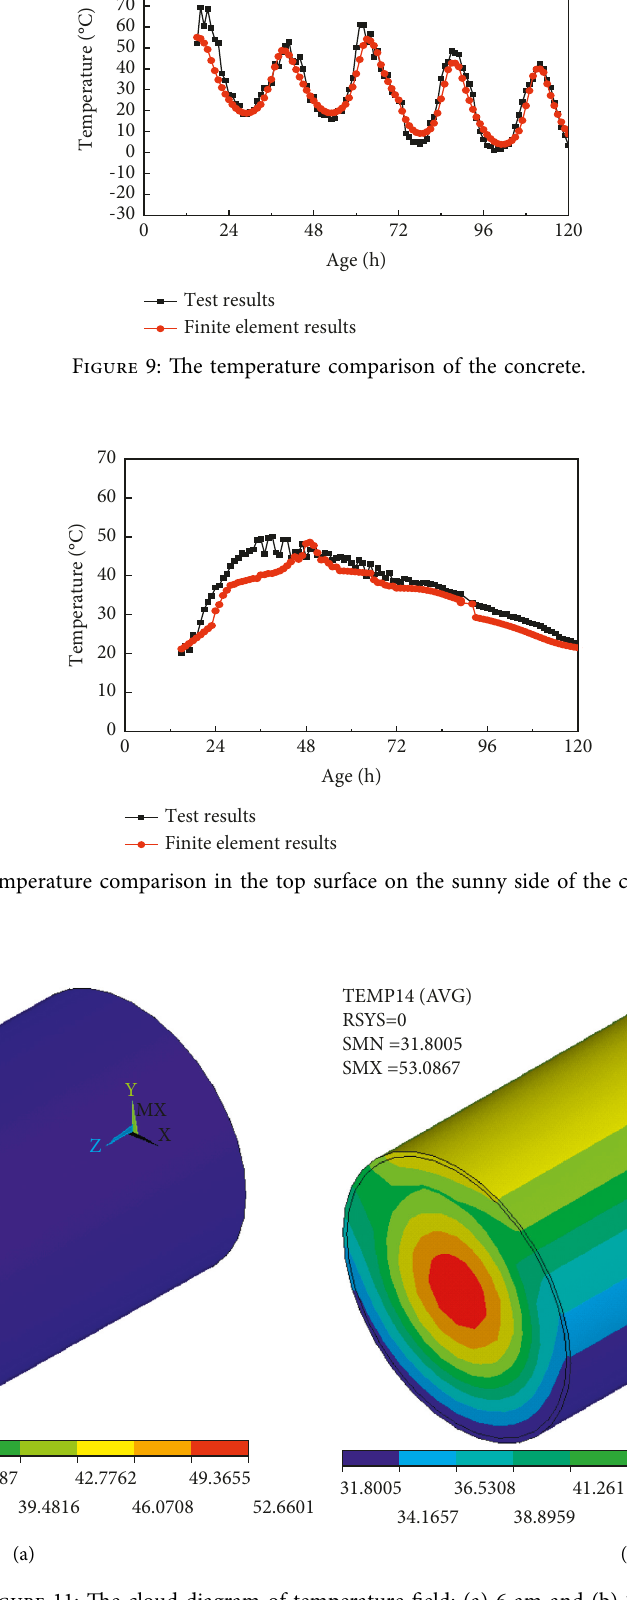
Figure 11: The cloud diagram of temperature field: (a) 6 am and (b) 2